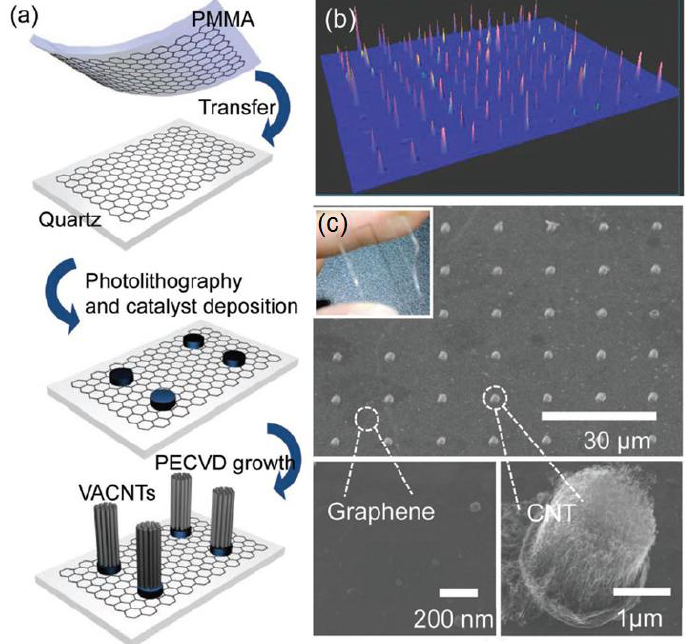
Figure 5. ( a ) Fabrication schematics of graphene/vertically aligned carbon nanotube (CNT) hybrid structure on quartz; ( b ) a 3D image of CNT heights obtained from optical surface profiler; ( c ) scanning electron microscopy (SEM) images of graphene/vertically aligned CNTs on quartz substrates. The inset shows a digital photographic image of our optical element. Reprinted with permission from [16]. Copyright 2011, John Wiley and Sons. VACNT, vertically aligned CNT.